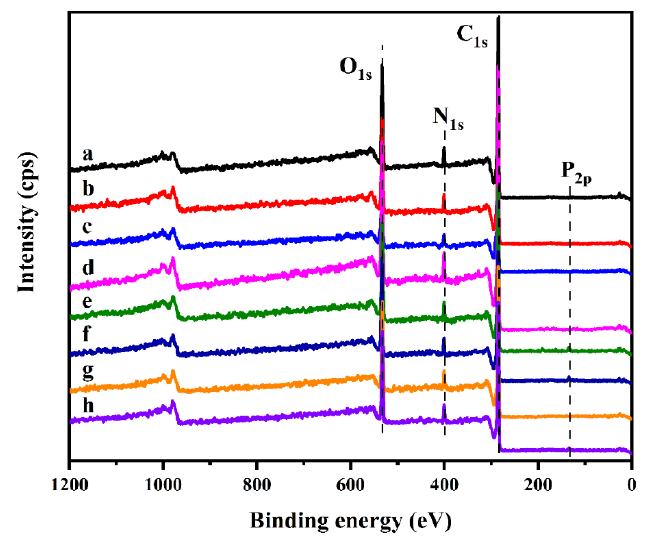
Figure 7. XPS curves of all RPUFs ( a ): neat RPUF, ( b ): RPUF-MOF/MWCNT 1, ( c ): RPUF- MOF/MWCNT 2, ( d ): RPUF-MOF/MWCNT 3, ( e ): RPUF-T, (f): RPUF-T-MOF/MWCNT 2, ( g ): RPUF-C-MOF/MWCNT 2, ( h ): RPUF-T/C-MOF/MWCNT 2.